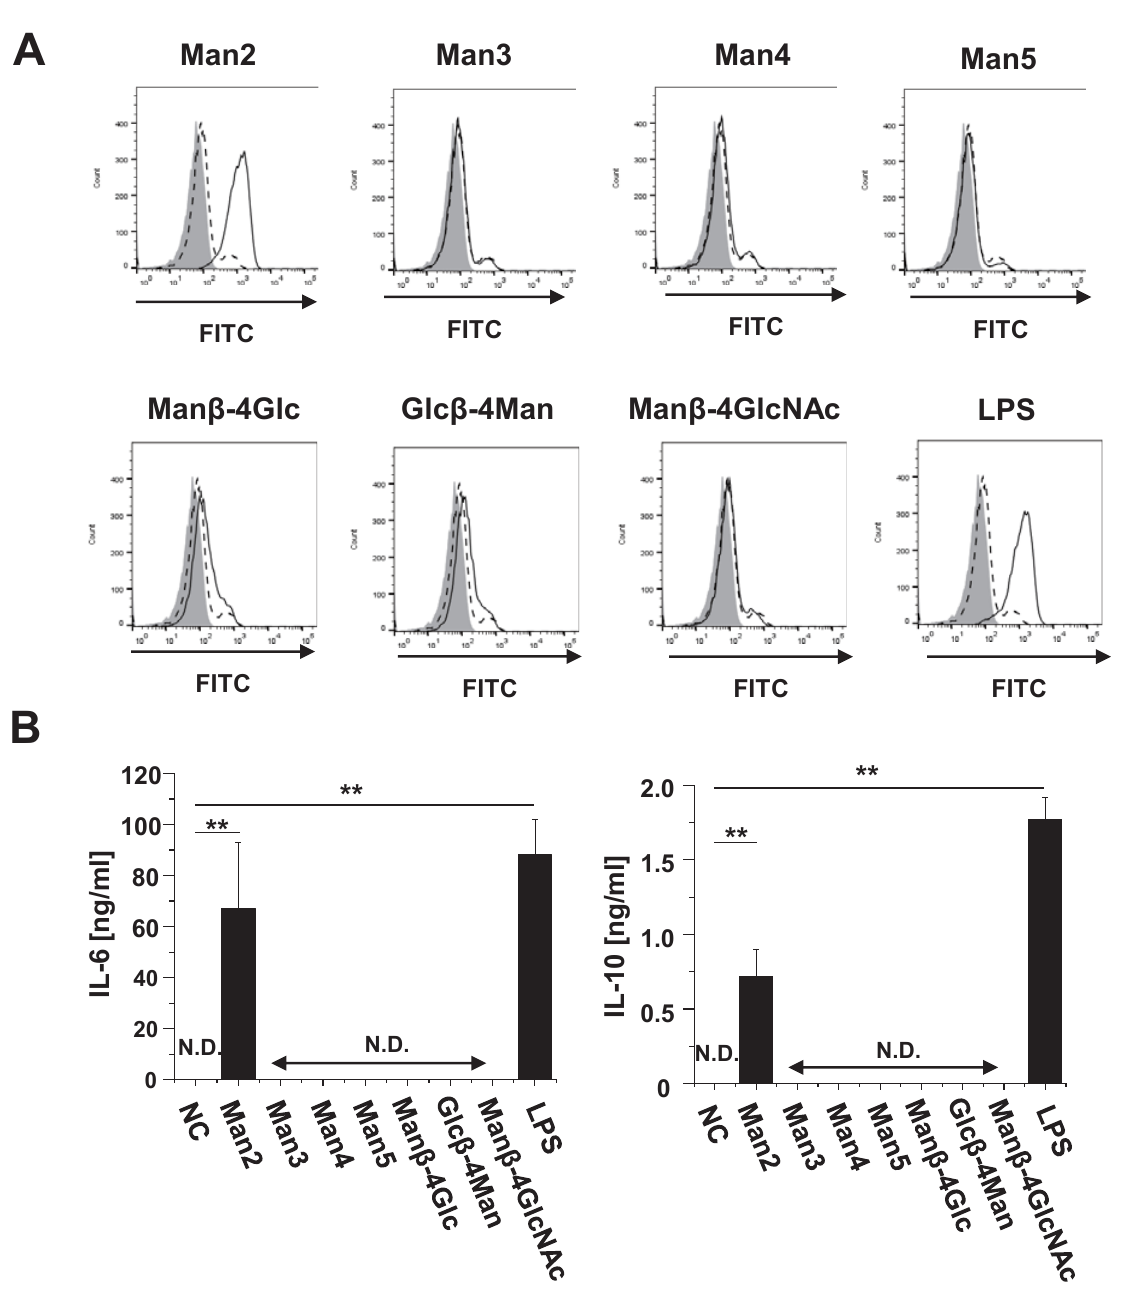
Figure 2. The stimulatory effect of mannooligosaccharides on RAW264.7 cells. ( A ) RAW264.7 cells (1 × 10 6 cells/mL) were stimulated with either 200 µ M of the indicated mannooligosaccharides, 1.0 µ g/mL of LPS or cultured only in medium for 24 h. Expression levels of CD40 on the cell surface were analyzed by FACS. Grey area: unstimulated and unstained cells, dashed lines: unstimulated and mAb-stained cells, solid lines: stimulated and mAb-stained cells. ( B ) The concentrations of IL-6 and IL-10 in the cell culture supernatants of RAW264.7 cells (1 × 10 6 cells/mL) upon stimulation with either 50 µ M mannooligosaccharides or 1.0 µ g/mL of LPS were determined by ELISA. ** p < 0.01 in Dunnett’s test. The data are representative for three independent experiments. All bar graphs show mean ± standard deviation (SD). N.D. (not detectable): <31.25 pg/mL (IL-6 and